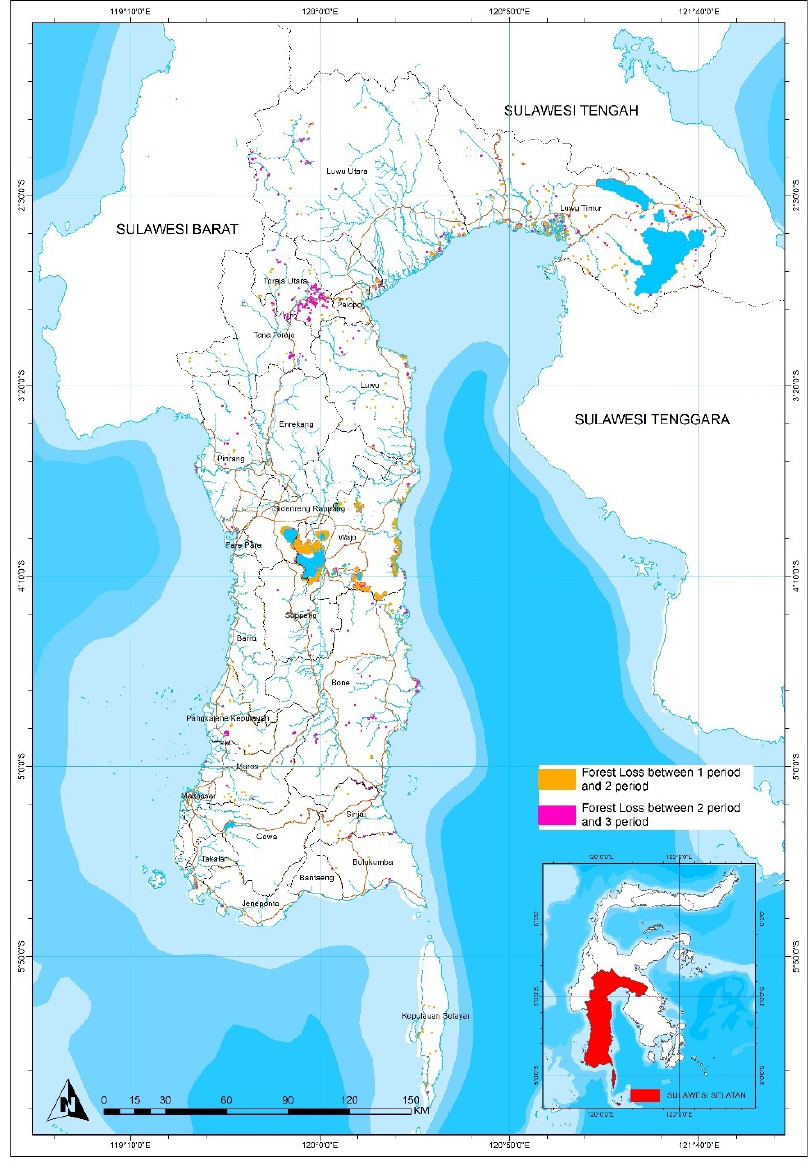
Figure 7. Distribution map of illegal logging events in Sulawesi Selatan in 2021.